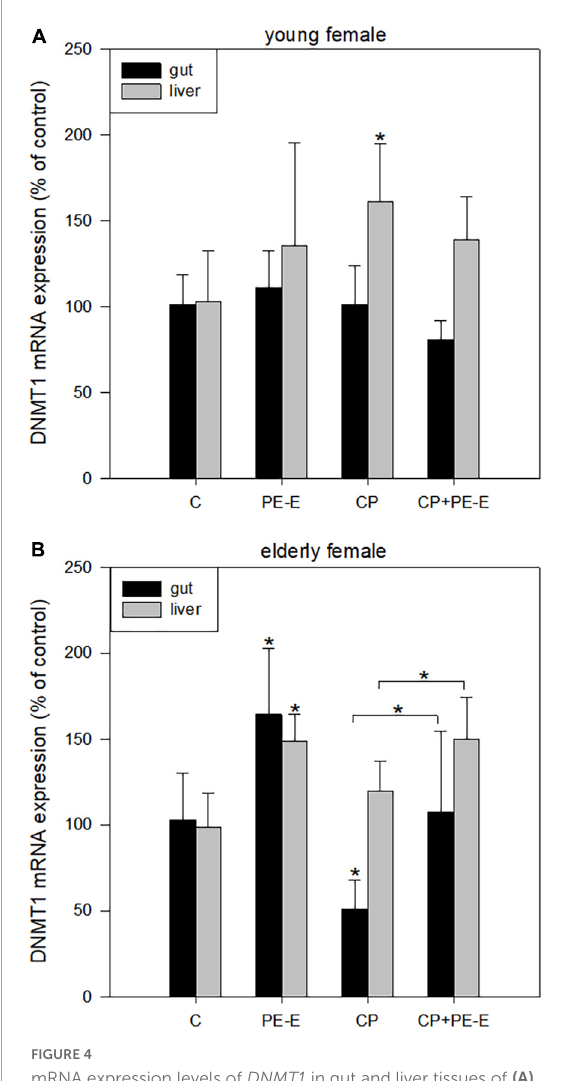
FIGURE4 mRNA expression levels of DNMT1 in gut and liver tissues of (A) young and (B) elderly female mice. C, negative control group treated with water for 14 days; PE-E, Pleurotus eryngii control group treated with 600 mg/kg P. eryngii mushroom extract for 14 days; CP, positive control group treated with water for 14 days and 80 mg/kg cyclophosphamide the 14th day; CP+PE-E, administration of 600 mg/kg P. eryngii mushroom extract for 14 days and 80 mg/kg cyclophosphamide the 14th day. All values are expressed as the mean ± SD of six mice in each group. * p < 0.05 compared to control (water) ( t -test).